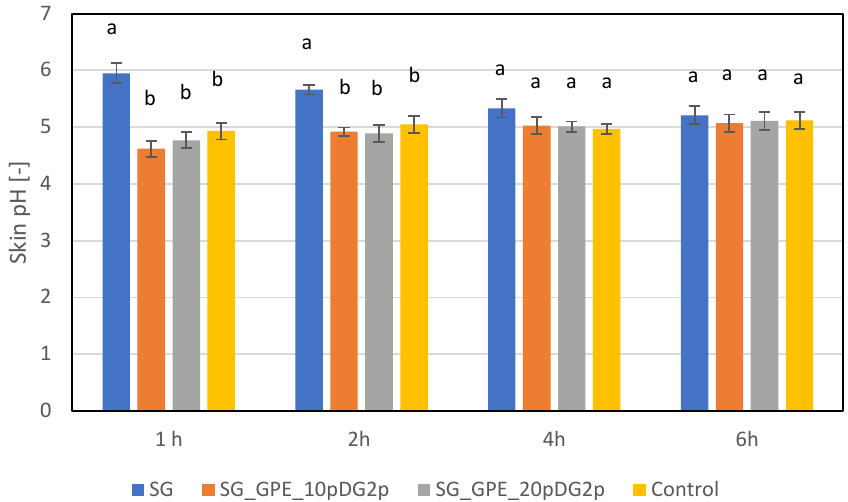
Figure 6. Influence of plant extracts on skin pH. The superscripts a and b denote significant ( p < 0.05) differences between the test extracts within the individual test times.